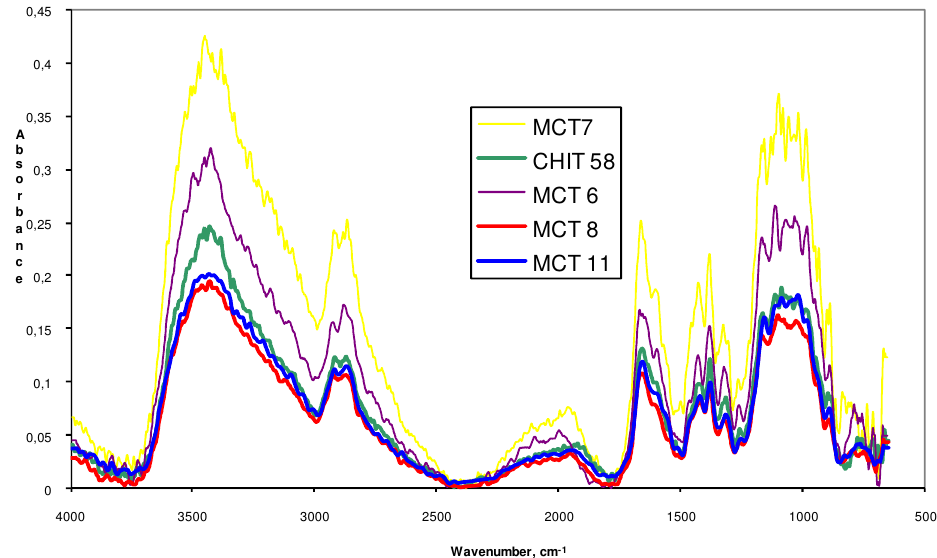
Figure 4. FTIR spectra of chitosan fibers (Chit 58) and modified β -TCP (MCT 6), and those modified with HAp (MCT 7), HAp/ β -TCP (1:1) (MCT 8) and HAp/ β -TCP (1:2) (MCT